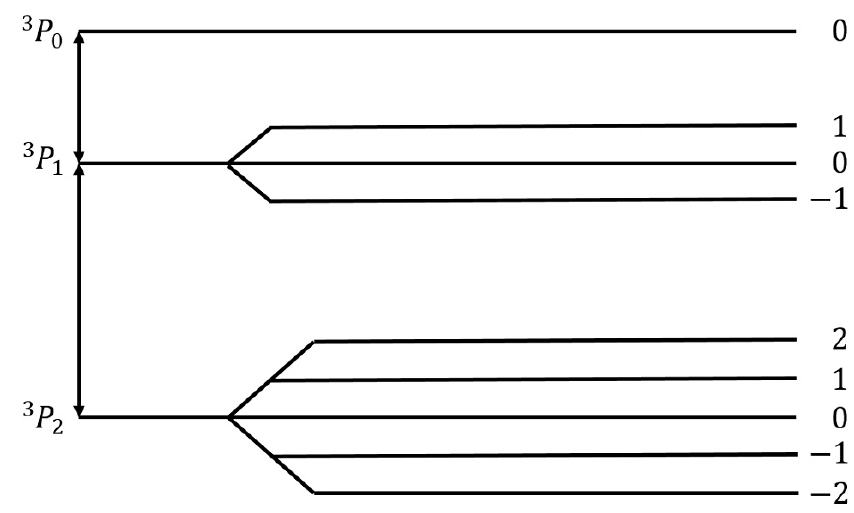
Figure 12. Splitting of the energy levels of an oxygen atom in a magnetic